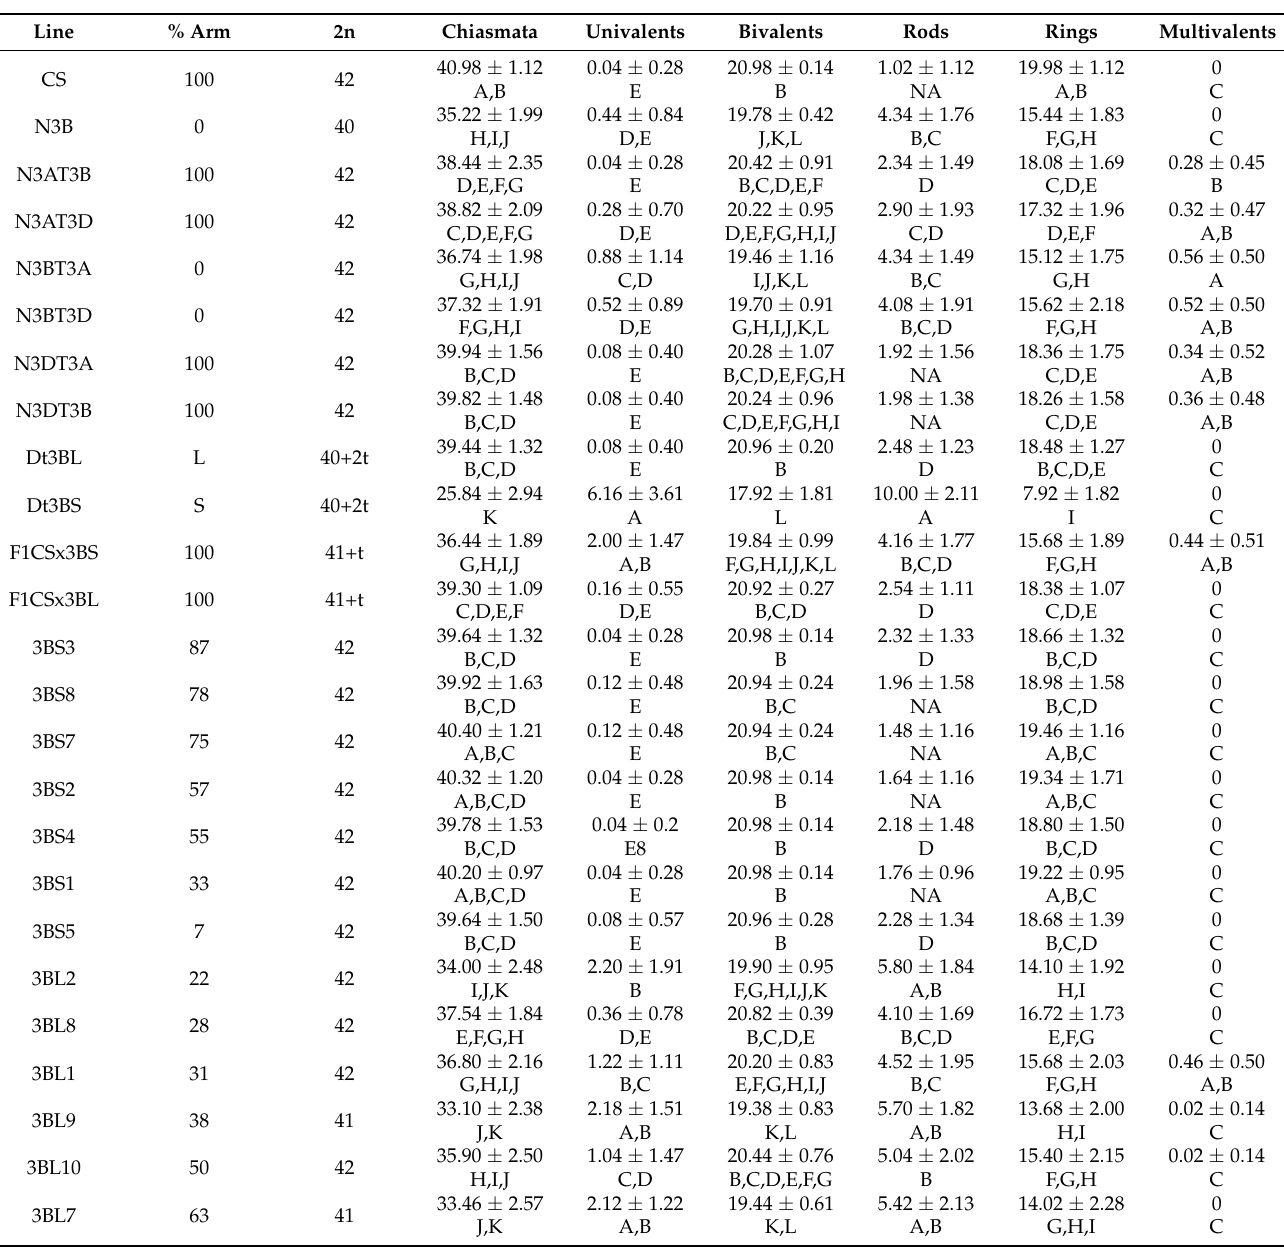
Table 1. Number of chiasmata in the different aneuploid lines. Average numbers of chiasmata, univalent, bivalent (rods and rings) and multivalent chromosomes for the wild-type Chinese Spring line (CS) and for the aneuploid lines (nullisomic-3B (N3B); nullisomic-tetrasomic-(NxxTxx); ditelosomic Dt3BL and Dt3BS; hybrids CS x ditelosomic (F1CSx3BS and F1CSx3BL); deletion lines (3BSxx or 3BLxx). % arm: percentage of the chromosome 3B or chromosome arm present (L: Long arm; S: Short